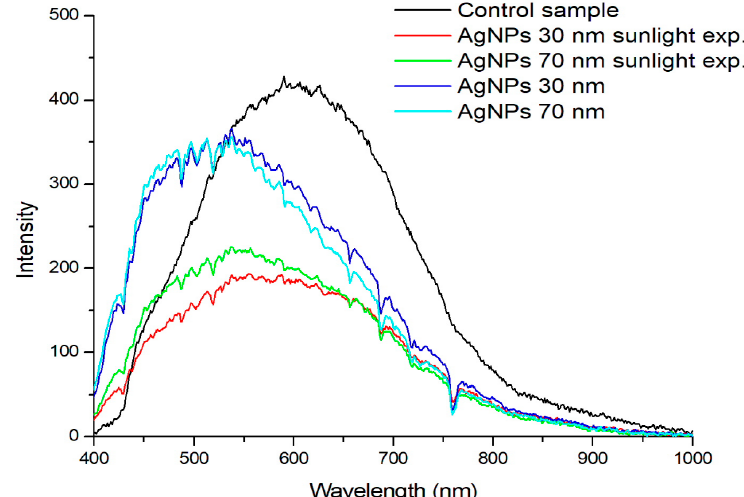
Figure 7. Mean reflectance spectrum of fabrics.